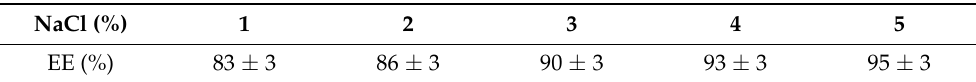
Table 4. p –nitrophenol extraction efficiency (EE) depending on NaCl source phase concentration (after 150 min of